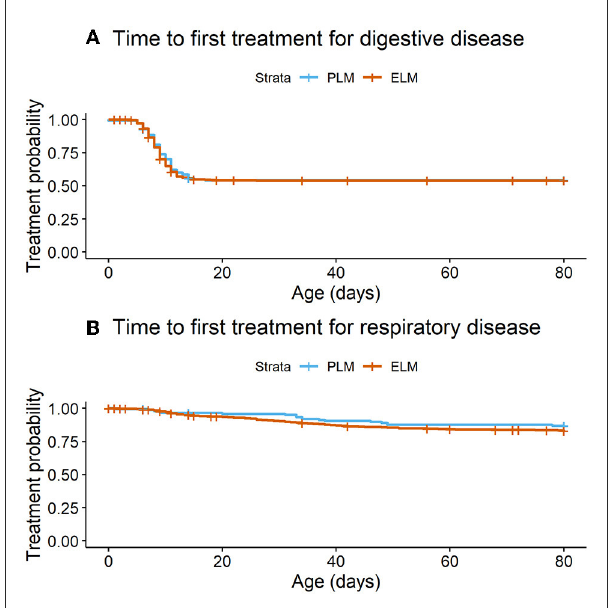
FIGURE3 Time to occurrence of diseases in the pre-weaned life (birth to 80d of life) by maternal plasma NEFA category in the last 2 weeks of gestation. PLM (physiological lipid mobilization = 1,373; plasma NEFA < 0.3mM; blue line), ELM (excessive lipid mobilization = 138, plasma NEFA ≥ 0.3mM; red line). (A) Time to first treatment for digestive disease ( P = 0.83). (B) Time to first treatment for respiratory disease ( P = 0.23).